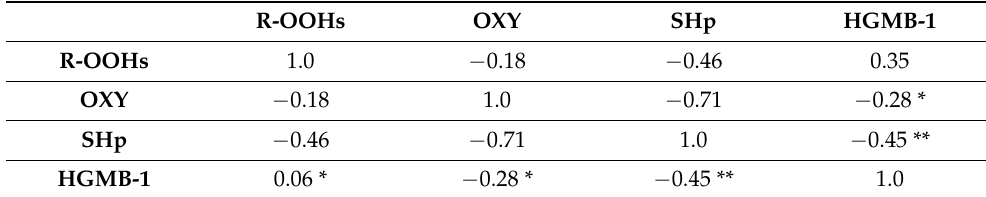
Table 4. The correlation between considered variables of oxidative stress in the G1 group